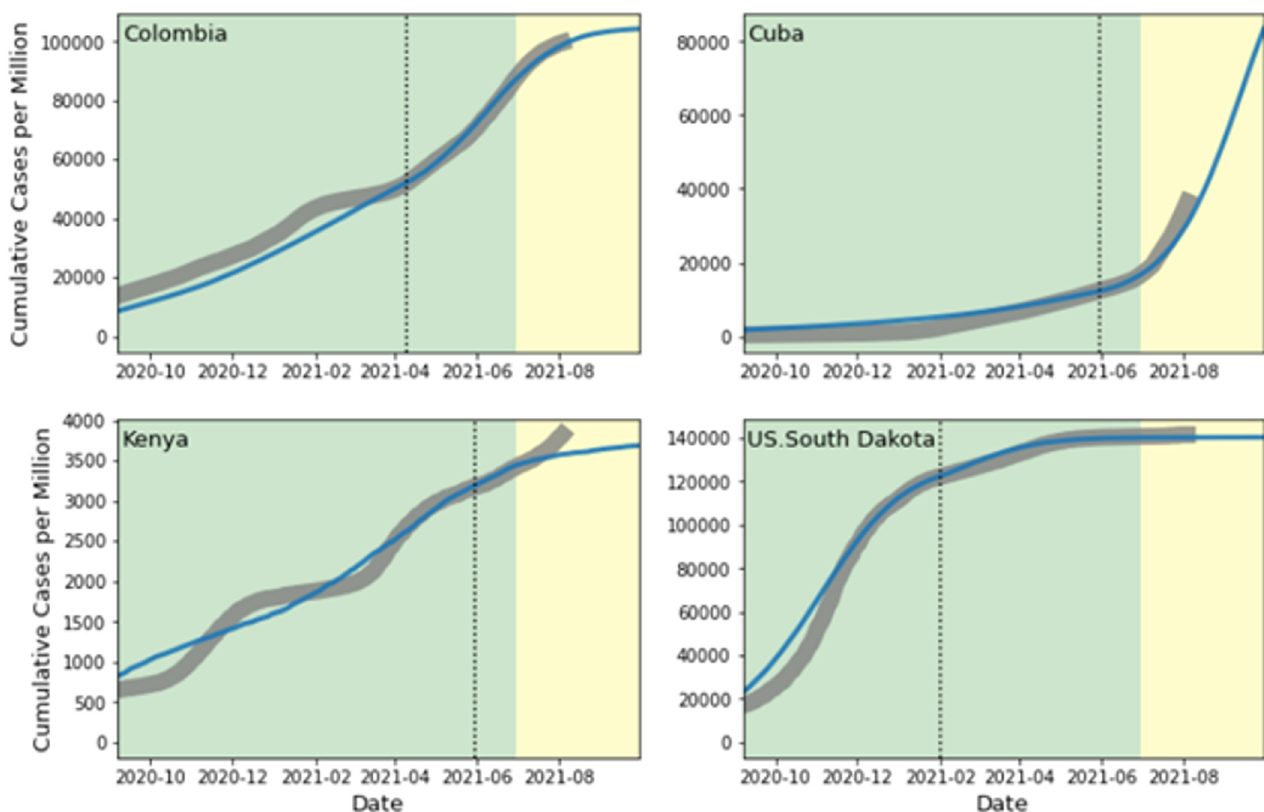
Fig 2. Model fitting for selected countries. Model fitting (shaded green) and out-of-sample validation (shaded yellow) in four selected countries. The grey curves are the observed cumulative cases per million, and the blue curves are the simulated results. The dotted lines signal the days when traveling, vaccination, and regional demographic characteristics are added to the